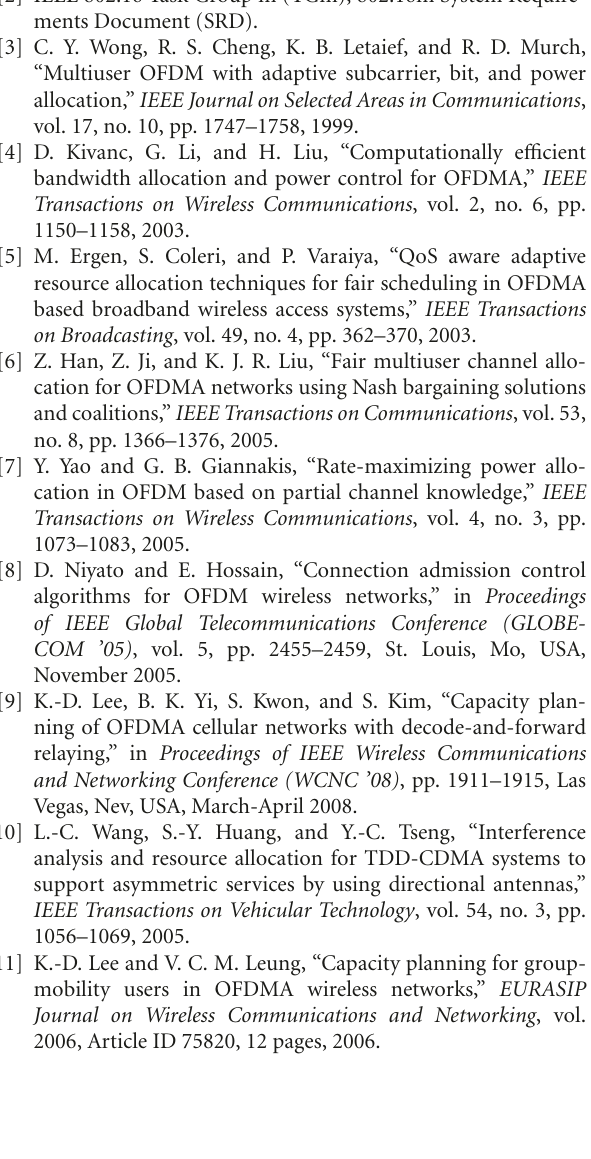
For di ff erent requirements of bit-error rates, Figure